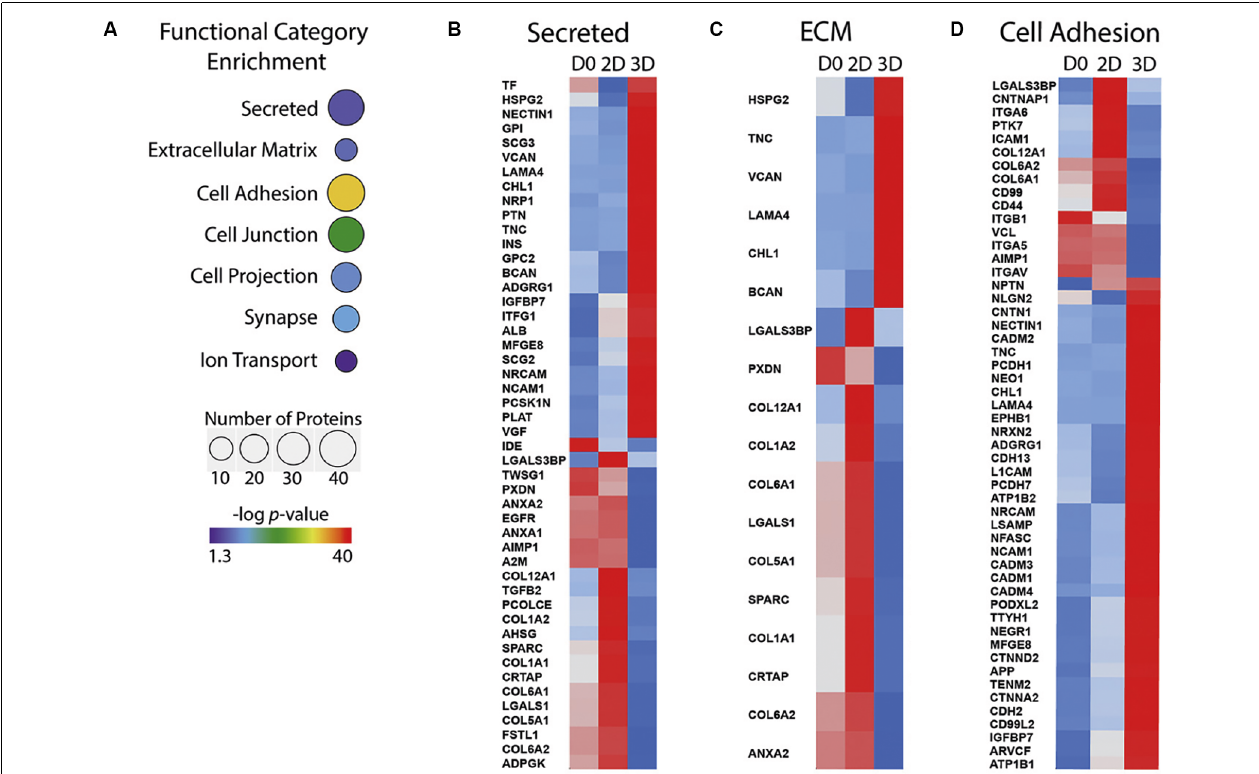
FIGURE 2 | ECM components expressed differ between 2D and 3D in vitro cultures of human iPSCs undergoing differentiation to NPCs. (A) Functional categories that are significantly over-represented in 3D iPSC to NPC differentiation, selected from proteomic analysis of 2D and 3D cultures. The number of proteins is indicated by sphere size, the p -value is indicated by colour. (B–D) Heatmaps showing protein abundance profile at day 0 (D0) of culture, day 30 of 2D culture (2D) and day 30 of 3D culture (3D). Z scores are colour-coded from blue (downregulation) to red (upregulation). Secreted proteins (B) , ECM (C) and cell adhesion protein (D) categories are shown. Adapted from Simão et al. (2018). iPSC, induced pluripotent stem cell; NPC, neural progenitor